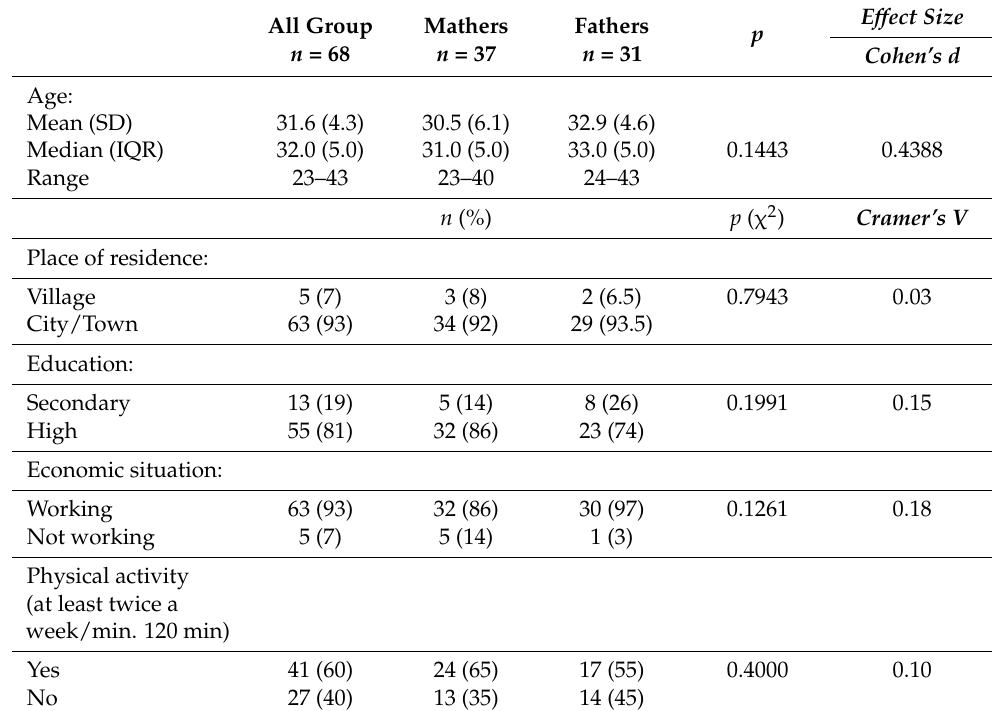
Table 1. Characteristics of the two study groups (the Mann–Whitney U test and χ 2 test).